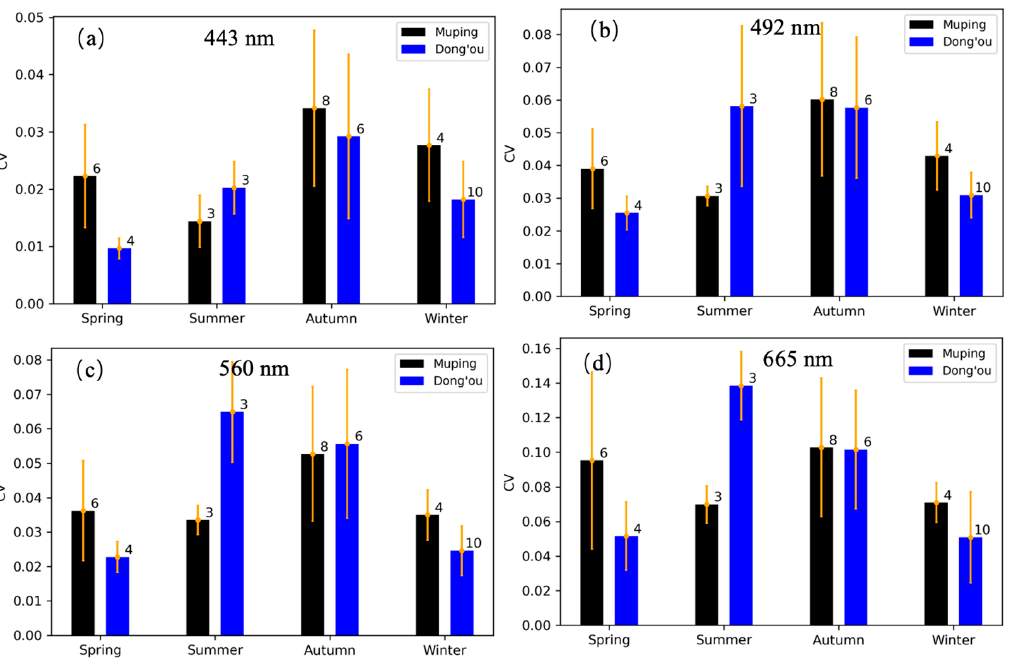
Figure 17. The mean and one standard deviation of coefficient of variation (CV) of remote sensing reflectance ( R rs ) at ( a ) 443, ( b ) 492, ( c ) 560, and ( d ) 665 nm at the Dong’ou (blue bars) and Muping (black bars) sites. The figure on top of the bar indicates the number of images used to compute the mean and standard deviation of CV.